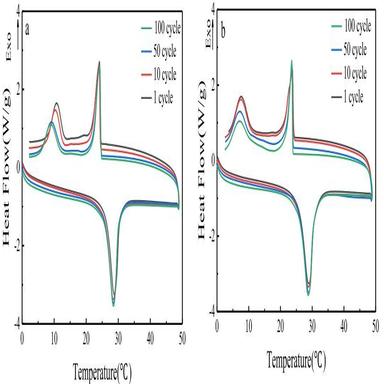
DSC curves of (a) PVA/PCM fibers and (b) cross-linked PVA/PCM fibers after 100 cycles of heating − cooling.